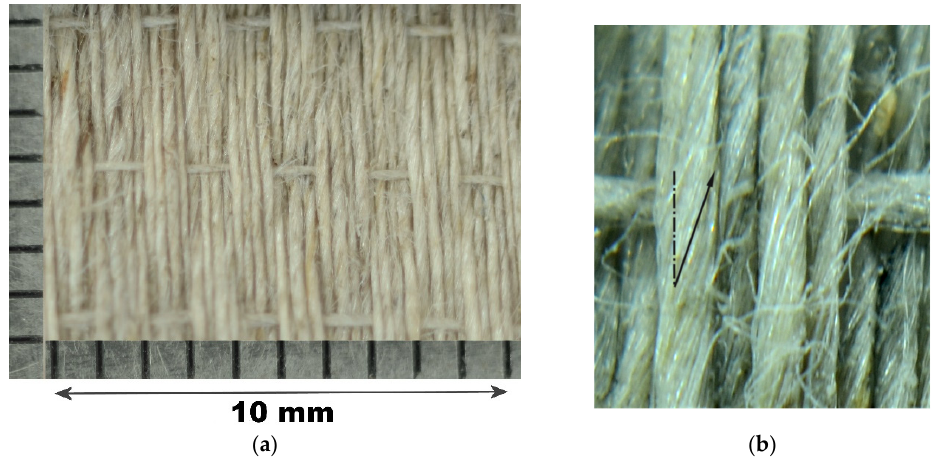
Figure 2. ( a ) Macro photo of the fabric; ( b ) Close ‐ up photo revealing the twisted fibres in yarn